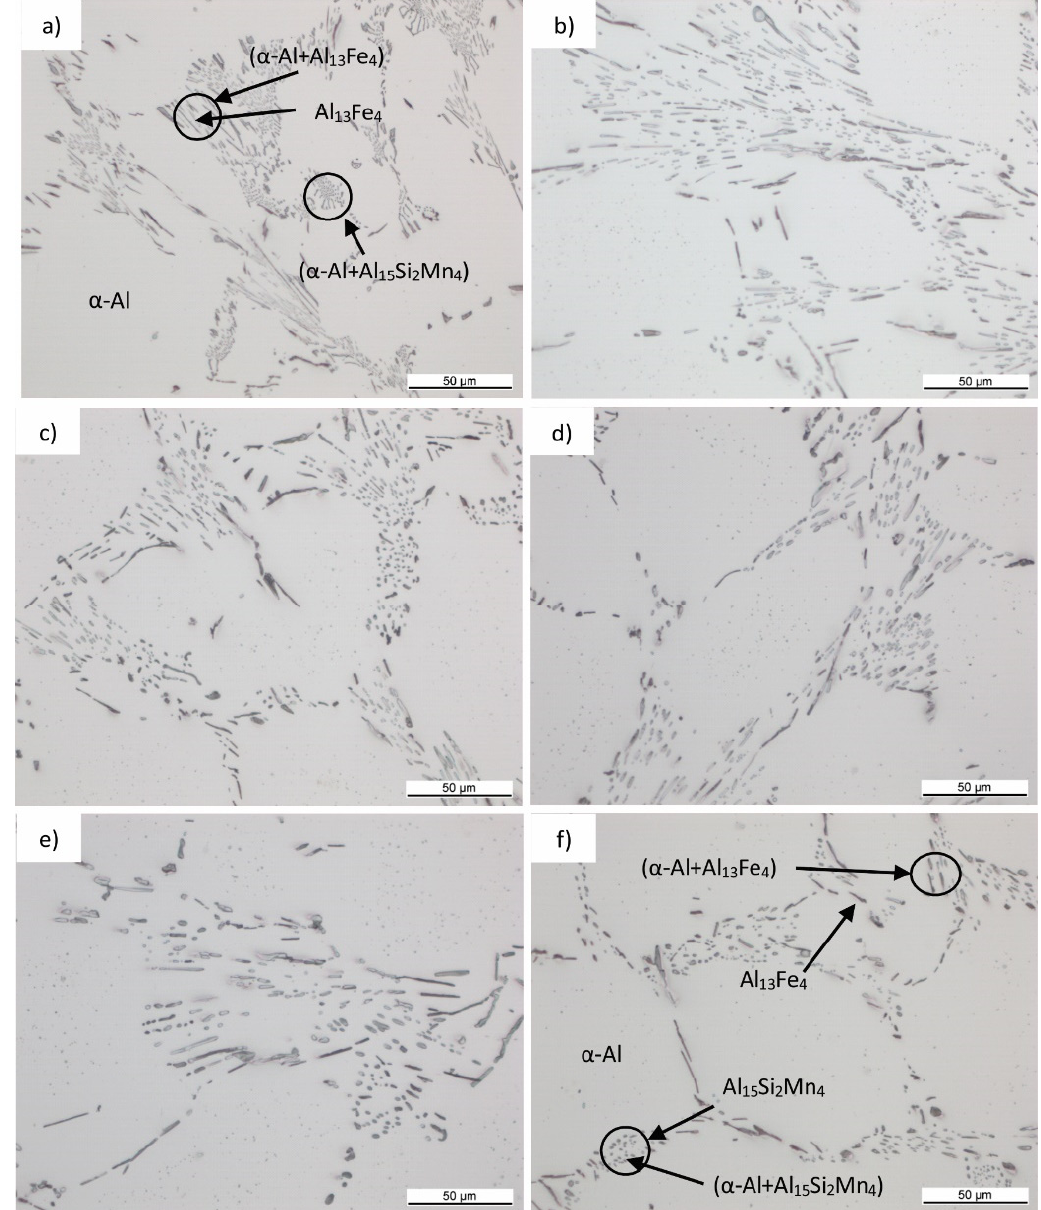
Figure 5. Microstructure of sample in as-cast state and homogenized samples at 600 °C at 500× magnification: in as-cast state ( a ) and after 4 h ( b ), 6 h ( c ), 8 h ( d ), 10 h ( e ) and 12 h ( f ).